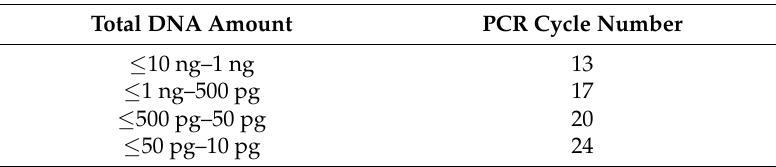
Table 1. PCR cycle numbers for varying input DNA